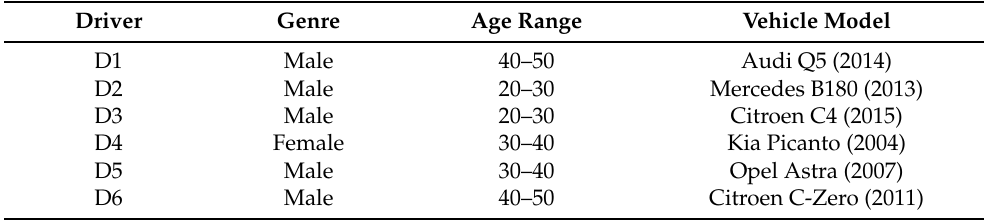
Table 2. Details about six drivers involved in the study with details about the genre, the age and the vehicle